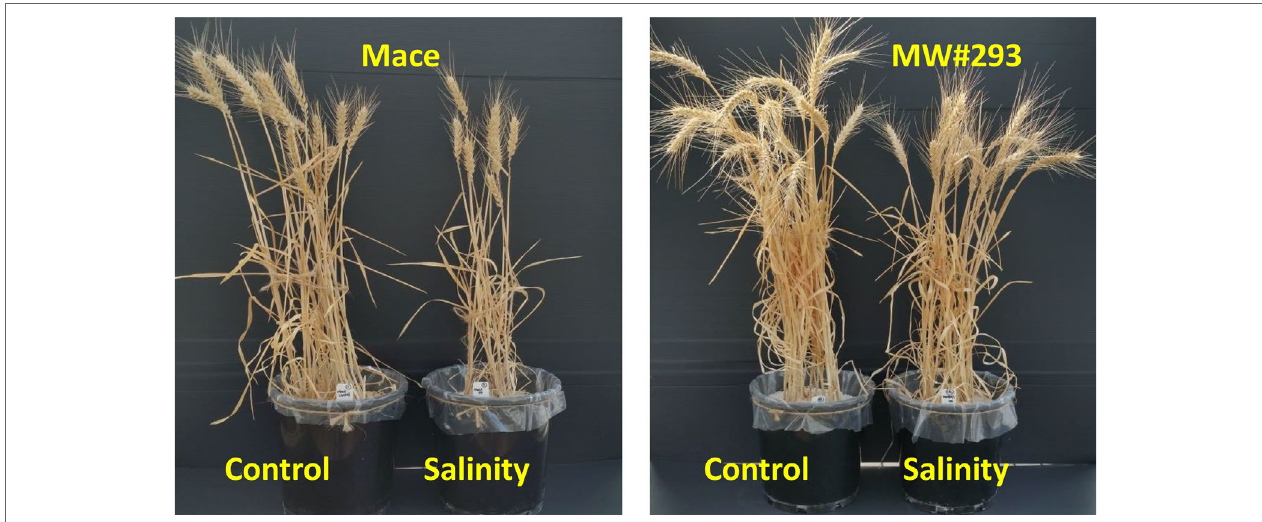
FIGURE 7 | Representative pots of bread wheat ( Triticum aestivum) cv. Mace and doubled-haploid line MW#293 grown under control and salinity (100 mM NaCl) in Experiment